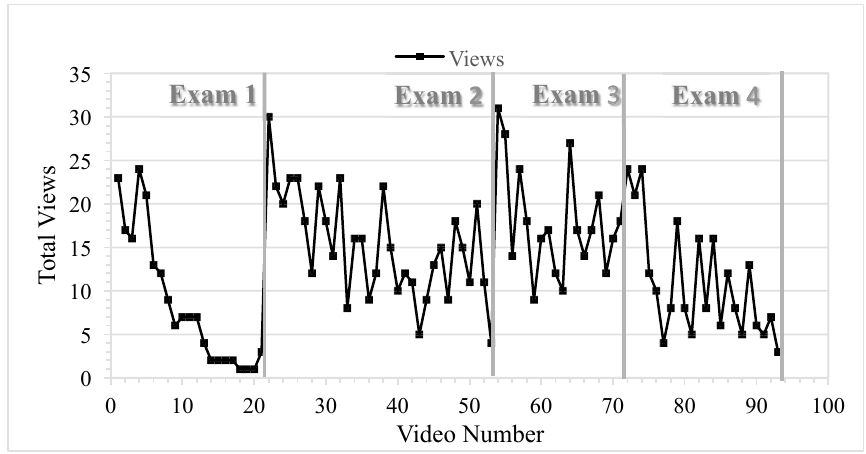
Fig. 2. Total Video Views plotted over chronological video order (vertical grey lines indicate last video before each